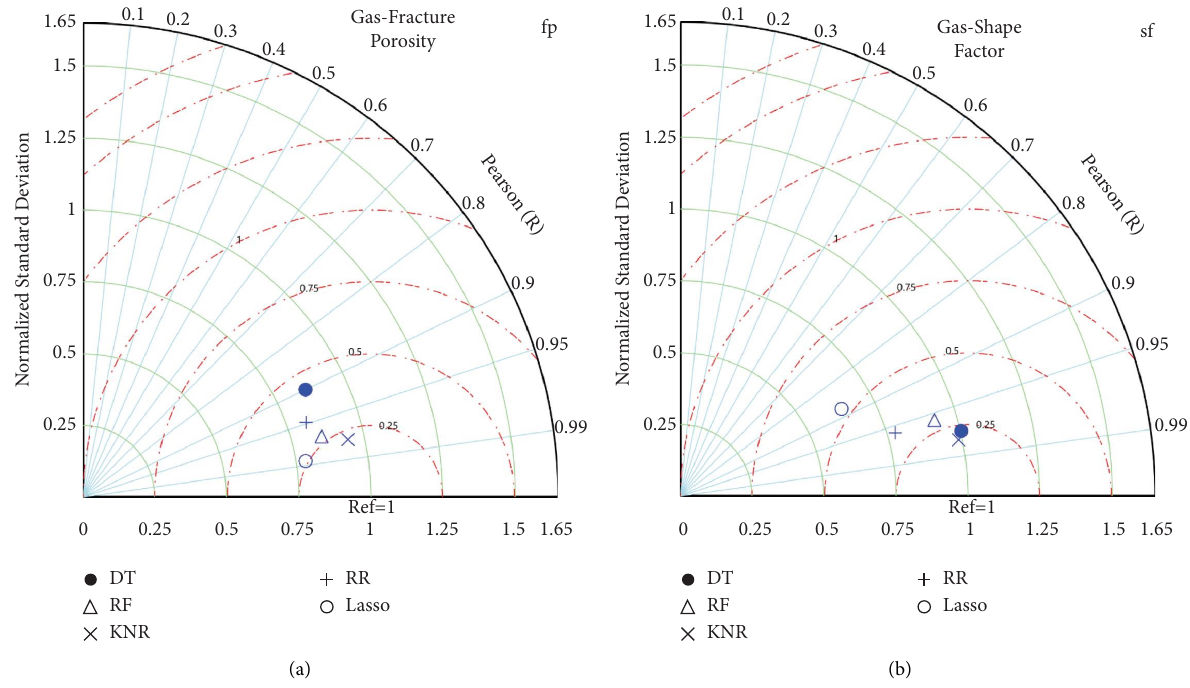
Figure 13: Taylor diagram presentation for the gas fow fracture porosity and shape factor prediction using diferent machine learning models.